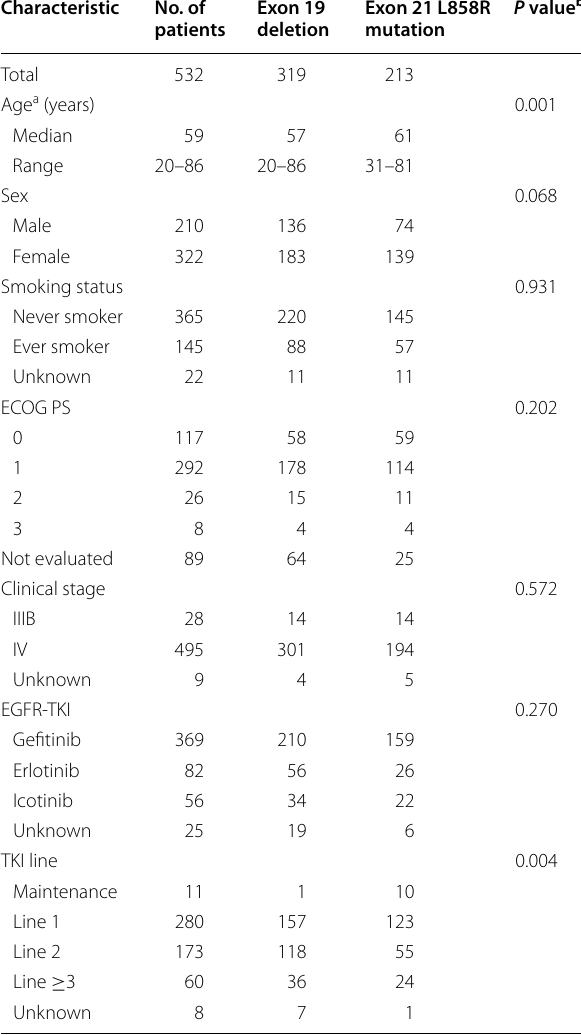
Table 1 Baseline characteristics of 532 patients with